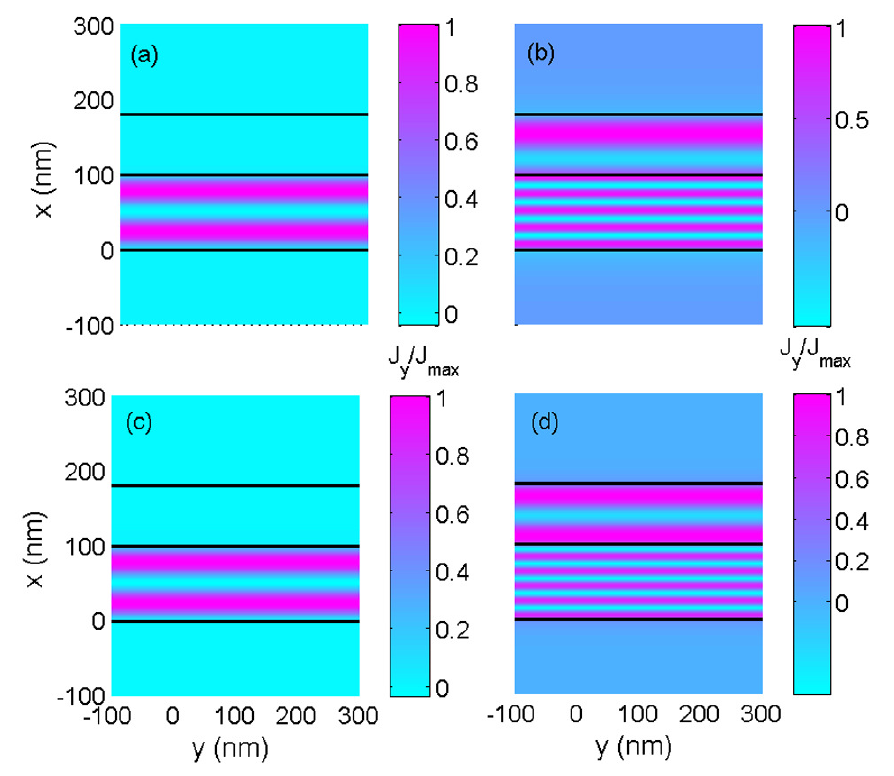
Figure 10. Probability current density within the graphene waveguide for the guided modes: ( a ) E = 94 meV, k 2 x h 1 = 5.7775; ( b ) E = 94 meV, k 2 x h 1 = 14.0965; ( c ) E = 110 meV, k 2 x h 1 = 5.7934; and ( d ) E = 110 meV, k 2 x h 1 =